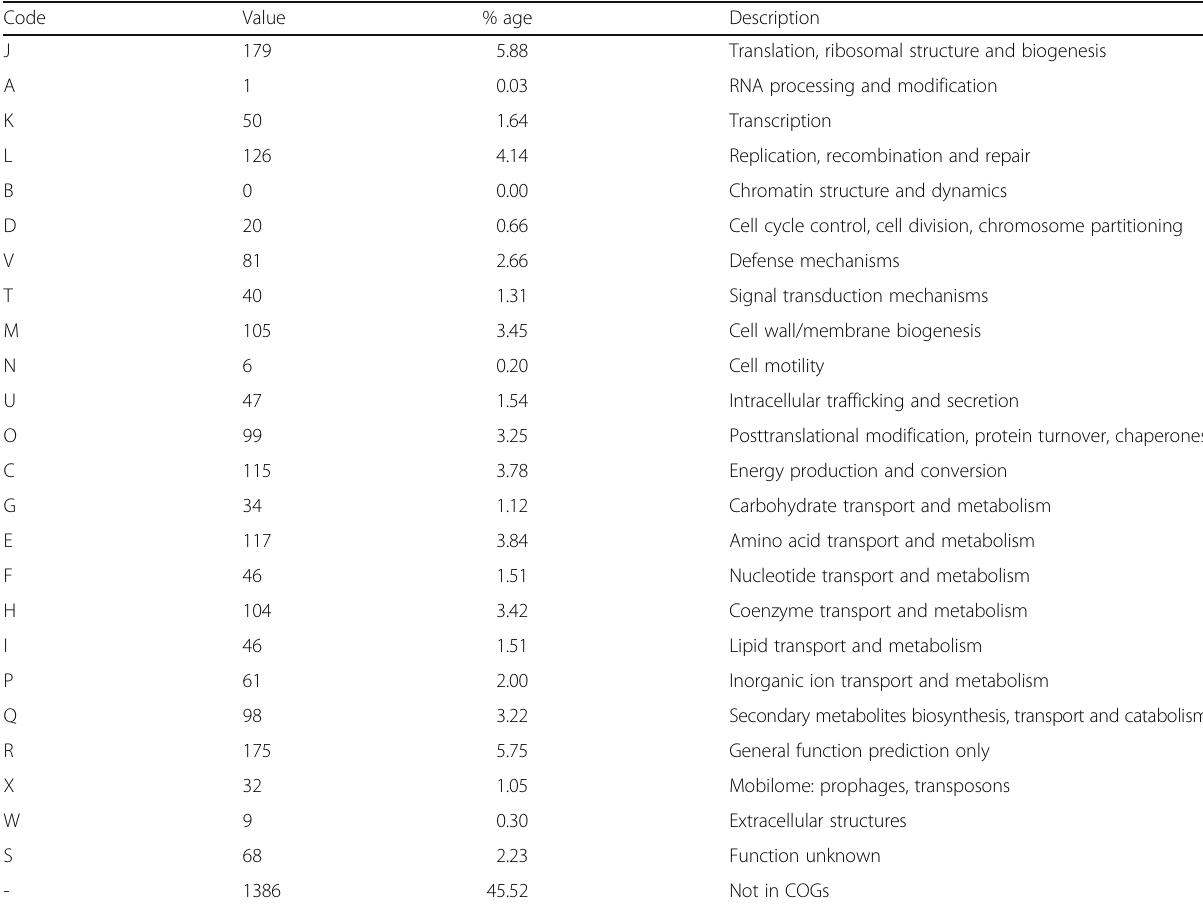
Table 4 Number of genes associated with general COG functional categories Code Value % age J